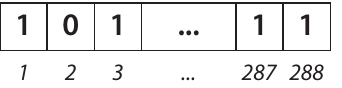
Figure 3. Representation of an individual solution used by